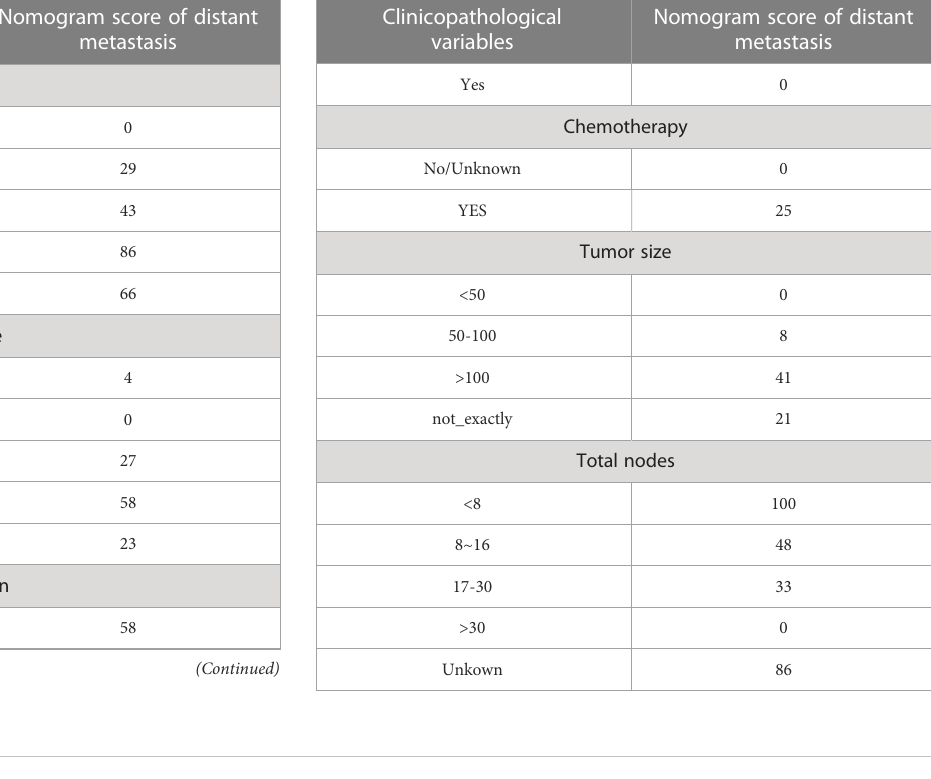
TABLE 4 Score of every clinicopathological variable in our nomogram.